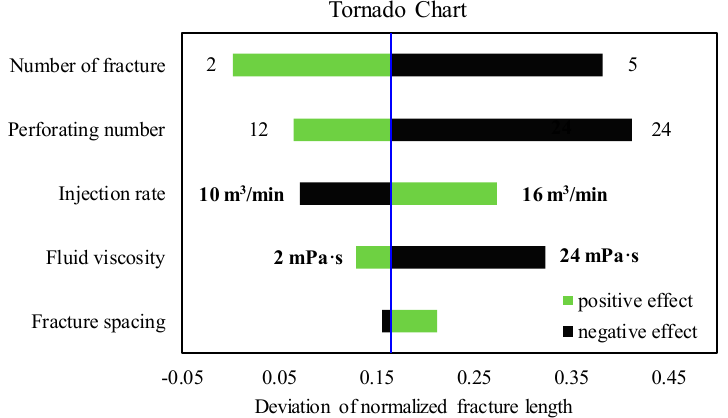
Figure 10. Rank of five uncertain parameters on the deviation of the normalized fracture length.